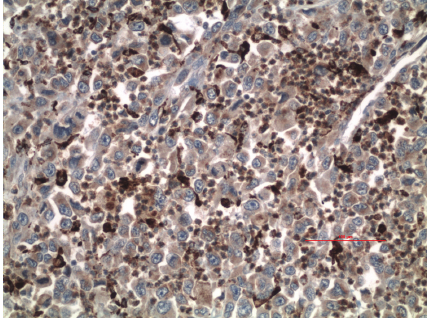
Figure 4: Malignant cells showing positive immunohistochemistry for CD 68